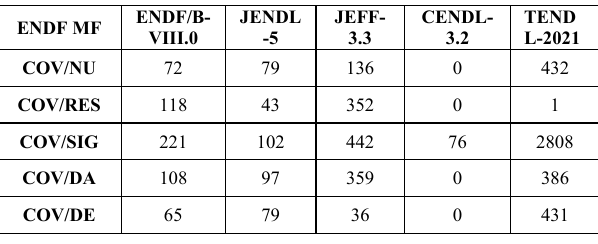
Table 1. Status of covariance evaluations in international evaluated